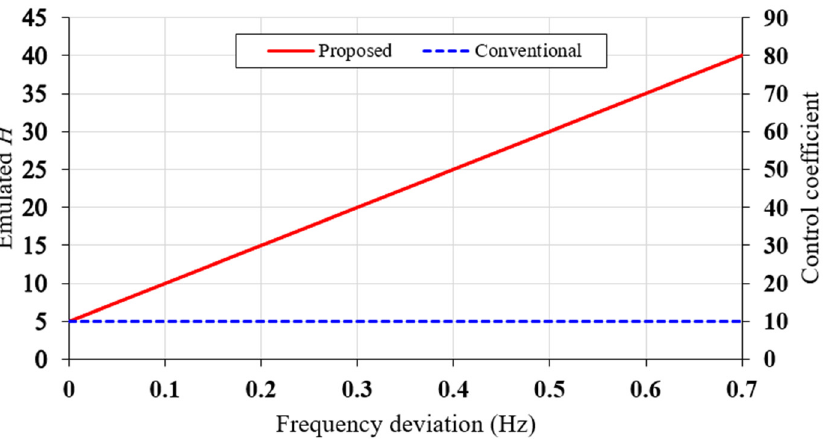
Figure 5. Comparison of inertia constant and control coefficient for the proposed ( k 2 = 1) and conventional inertial response emulated scheme.